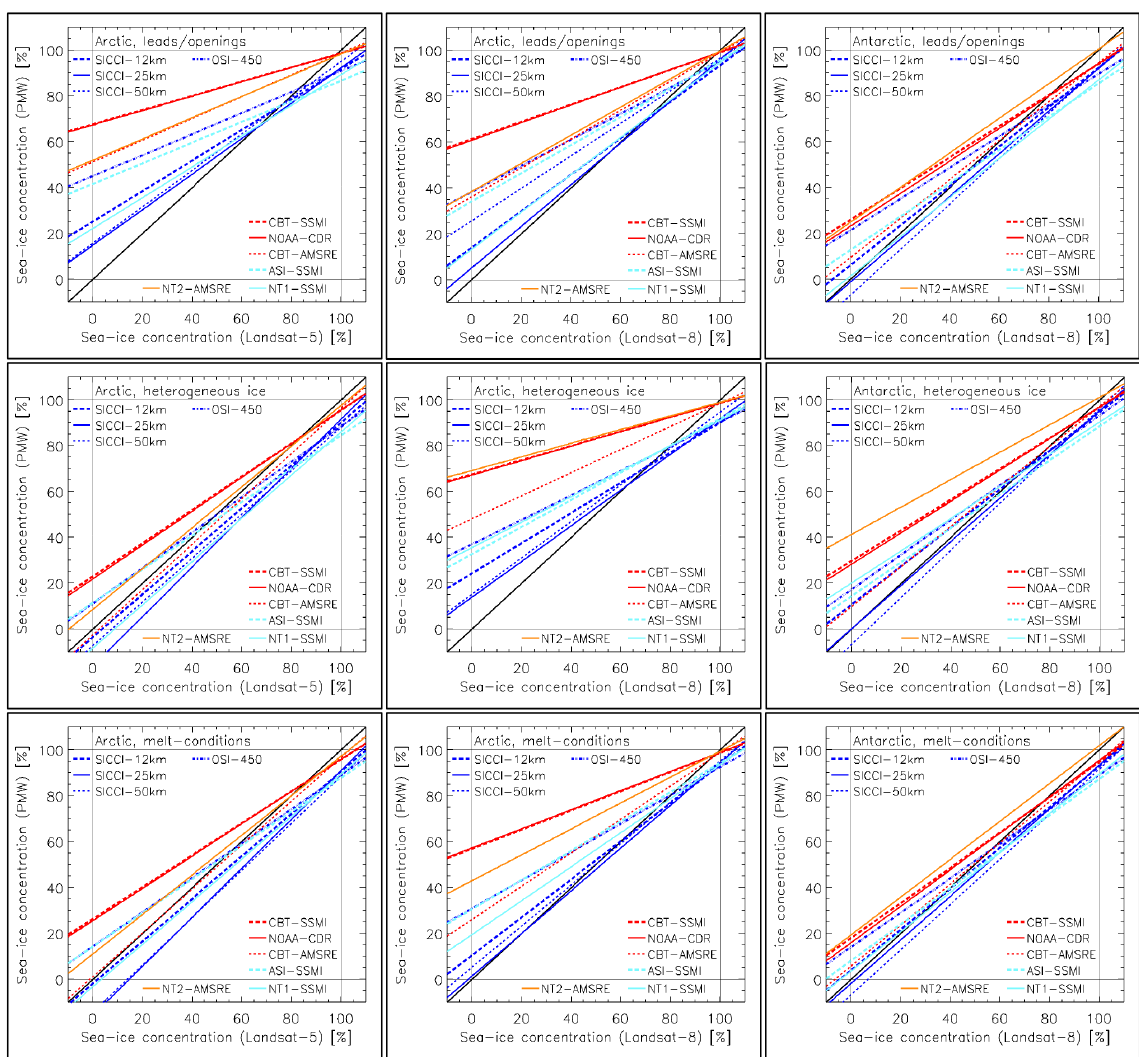
Figure 11. Summary of all linear regression lines obtained for the comparison between Landsat SIC and PMW SIC for all ice regimes – except high-concentration ice. Columns denote, from left to right, Landsat-5 Arctic (i.e., first-year ice), Landsat-8 Arctic (i.e., mixed first- year–multiyear ice and multiyear ice), and Landsat-8 Antarctic. Ice regimes are sorted per row from top to bottom. Different colors and line styles denote different products as indicated. The solid black line denotes the identity line. Note “AMSRE” refers to both AMSRE (Landsat-5) and AMSR2 (Landsat-8).